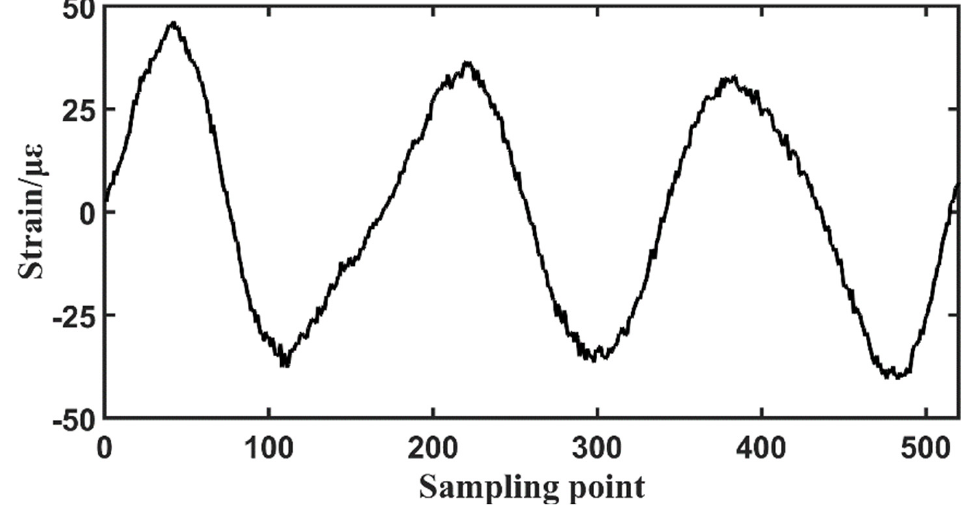
Figure 10. Time-domain response signal.